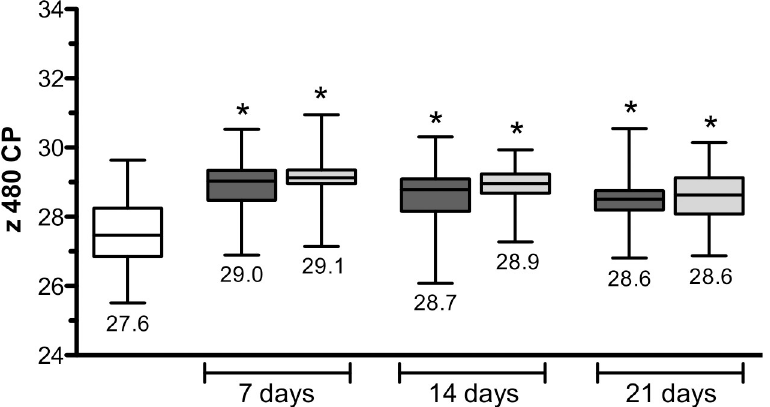
Fig 4. Freeze/Thaw stability assessment of x 480 DNA eluates. x 480 DNA eluates (n = 46 replicates) were spiked with 1.5x10 5 copies of genomic DNA purified from a laboratory culture of T . vaginalis . Once-weekly freeze-thaw cycles for 21 days, without and with magnetic glass particles (dark grey and light grey fill, respectively), was compared to crossing point (CP) values obtained immediately after purification (pre-freeze; white fill). Data are expressed as CP values from the T . vaginalis LDT; significant differences between each group compared to the pre-freeze CP values are denoted with an asterisk (ANOVA with Dunnett’s Multiple Comparison Test; p < 0.05).